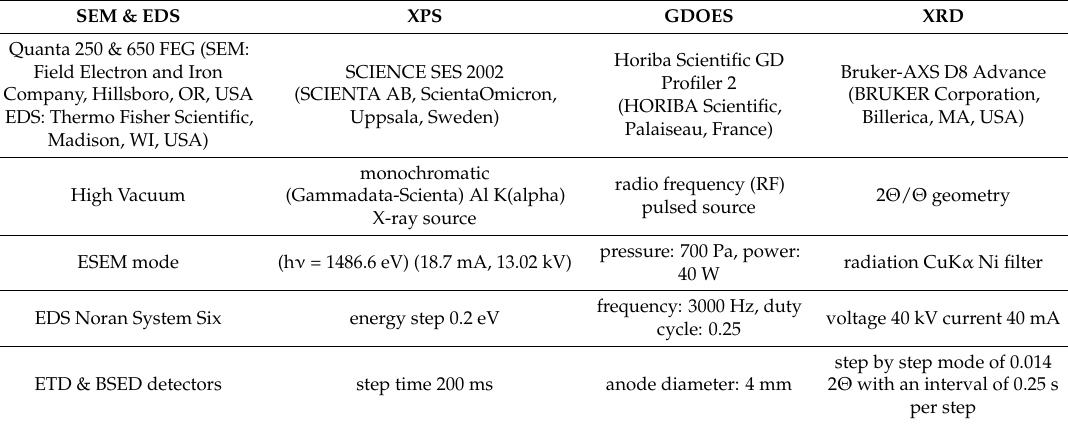
Table 3. Set-up descriptions of SEM, EDS, XPS, GDEOS, and XRD